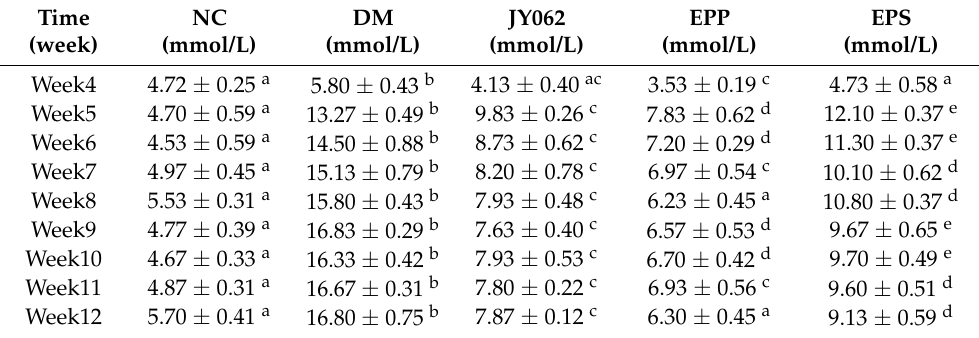
Table 3. Fasting blood glucose (FBG) of mice in the five groups from week 4 to week 12.